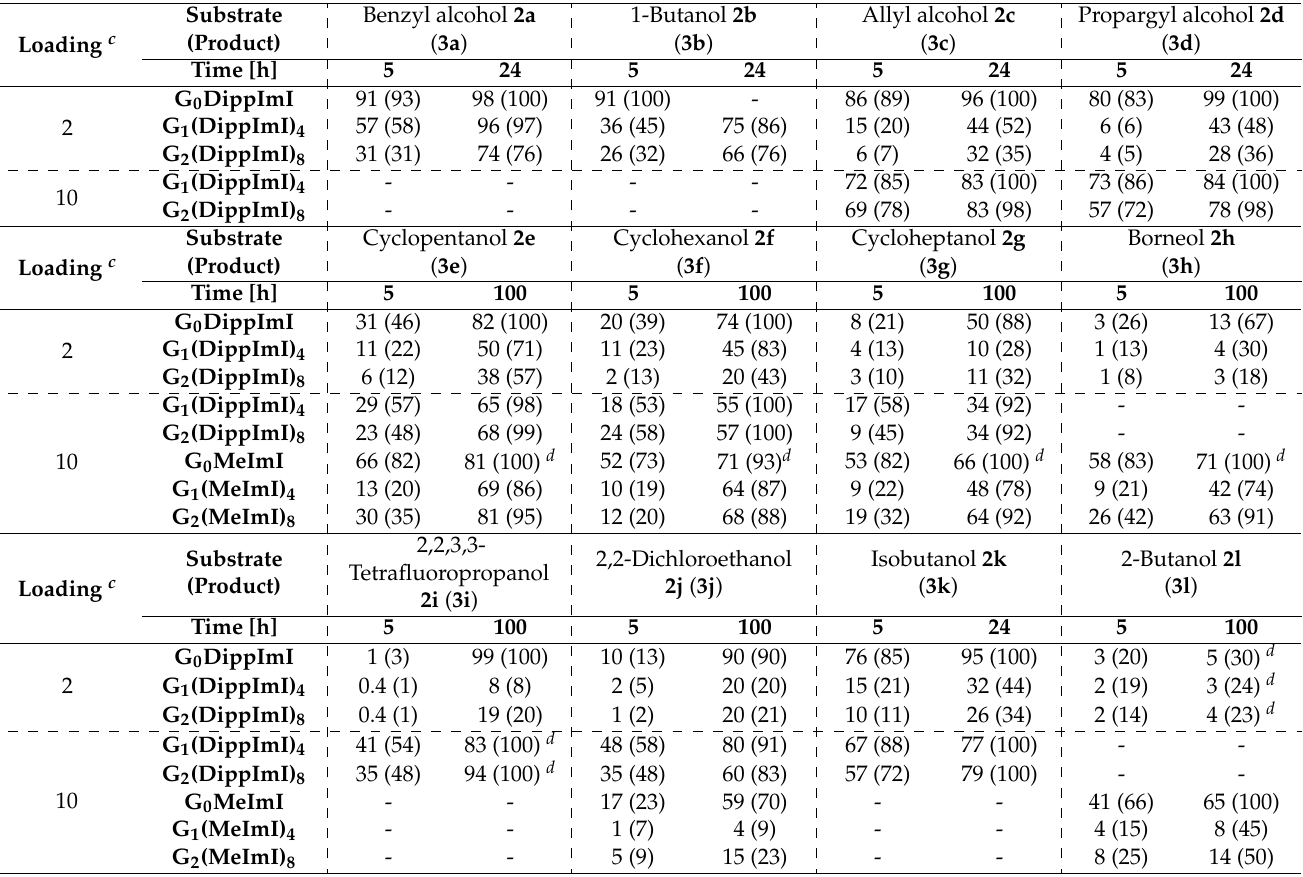
Table 2. Yields and conversions a obtained in redox esterification of cinnamaldehyde with various alcohols catalyzed by imidazolium dendrimers of generations 0 to 2 b